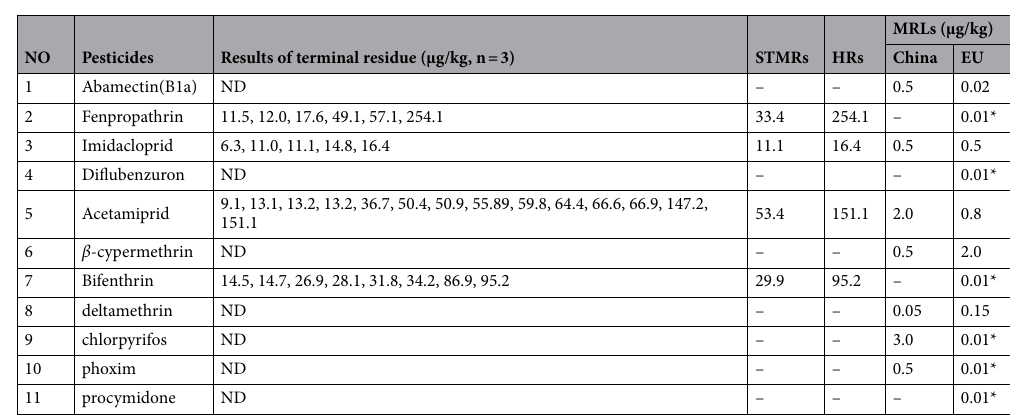
NO Pesticides Results of terminal residue (μg/kg, n =